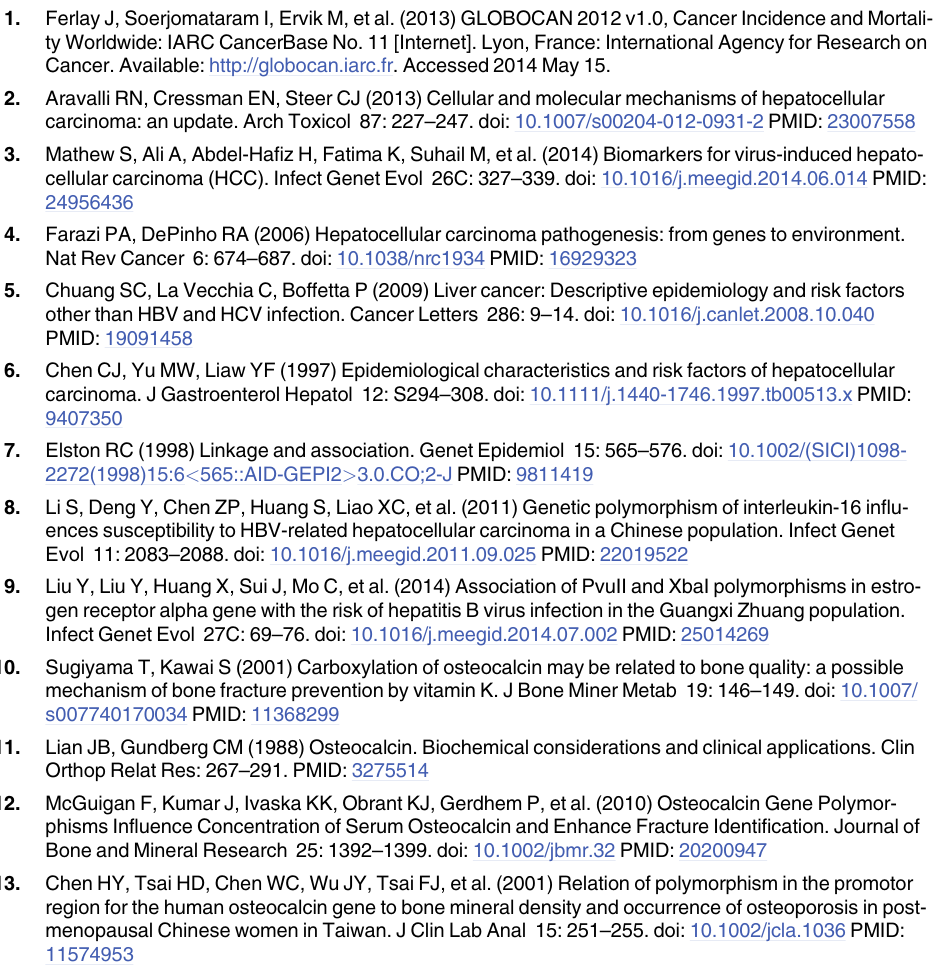
S2 Fig. Sequencing map of the genotypes for the rs1543297 polymorphisms of the osteocal- cin gene. Arrow in parts a – c indicates CC, CT and TT genotypes, respectively. (TIF) S1 Table. Comparison of genotype and allele frequencies in the healthy control subjects of our study and that from the HapMap